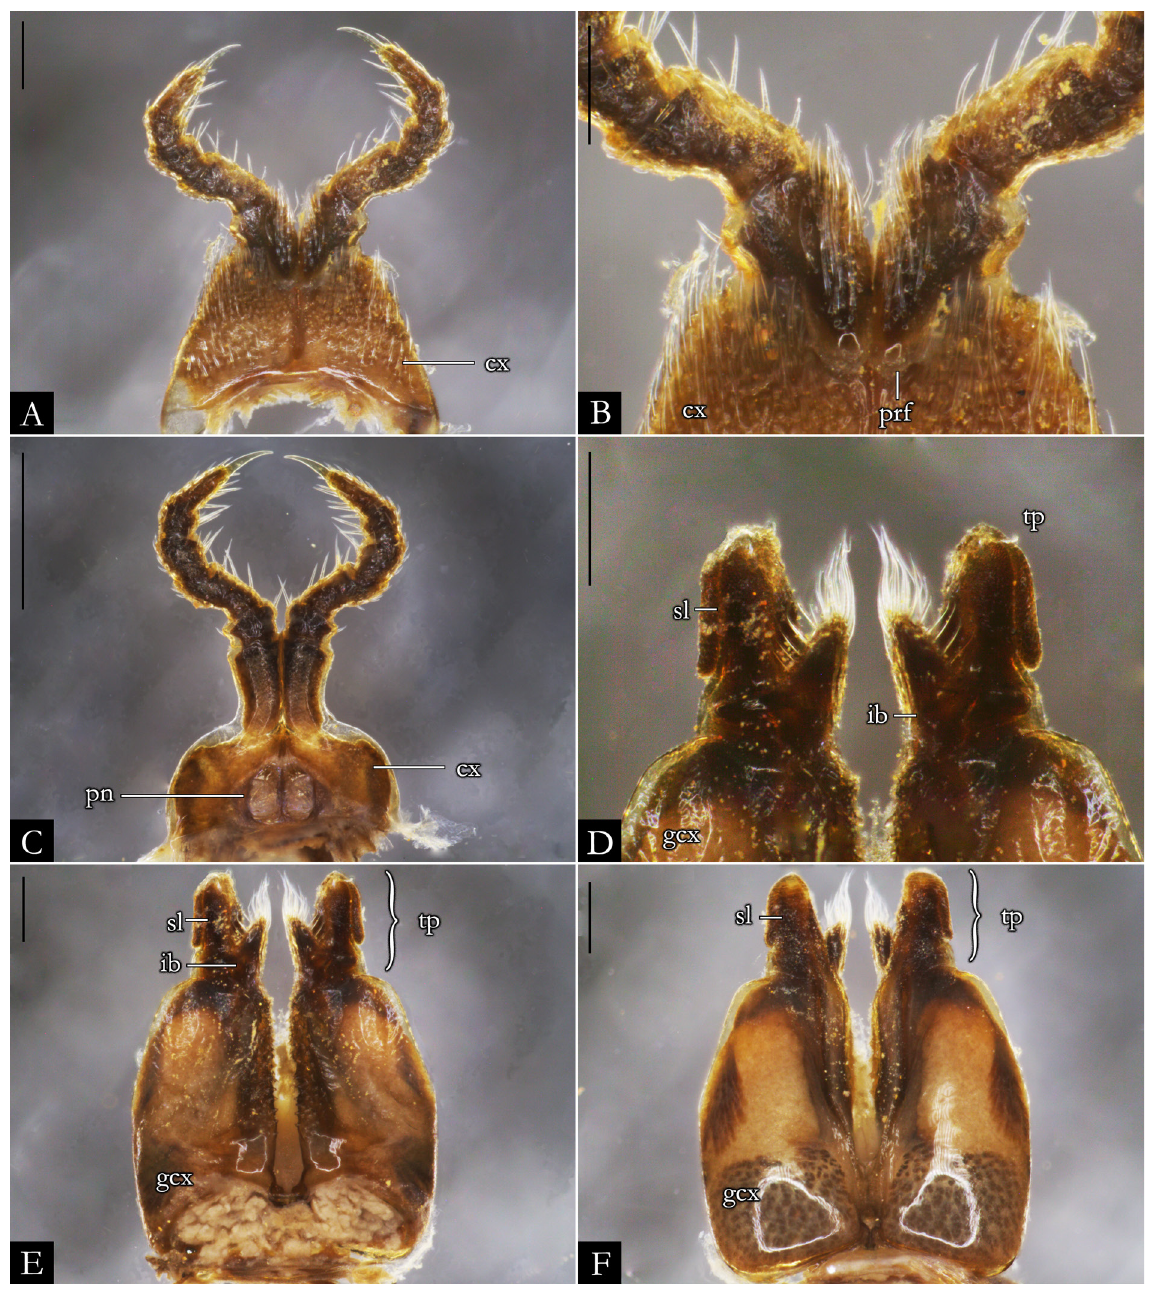
Fig. 128. Pseudonannolene spelaea Iniesta & Ferreira, 2013, ♂ (IBSP 5923). A . First leg-pair. B . Detail of prefemur. C . Second leg-pair. D . Detail of telopodites, in anal view. E . Gonopods, in anal view. F . Gonopods, in oral view. Abbreviations: see Material and methods. Scale bars = 0.2